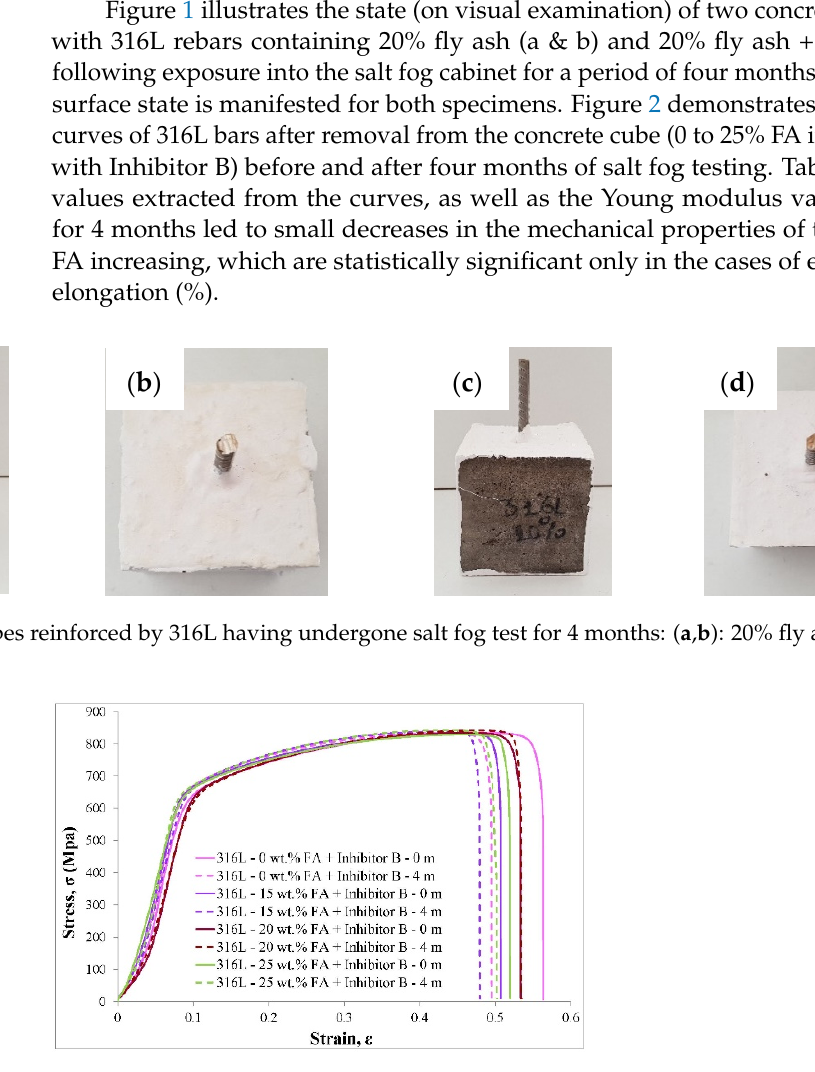
Figure 2. Tensile testing behavior of 316L bars reinforcing concrete that contains fly ash (0, 15, 20, 25% of cement) in combination with Inhibitor B prior to (0 m) and after salt fog testing (4 m). Table 1. Mechanical properties of 316L bars reinforcing concrete that contains fly ash (0, 15, 20, 25 % of cement) in combination with Inhibitor B prior to and after salt fog testing. Duration, Fly Ash, wt.% m